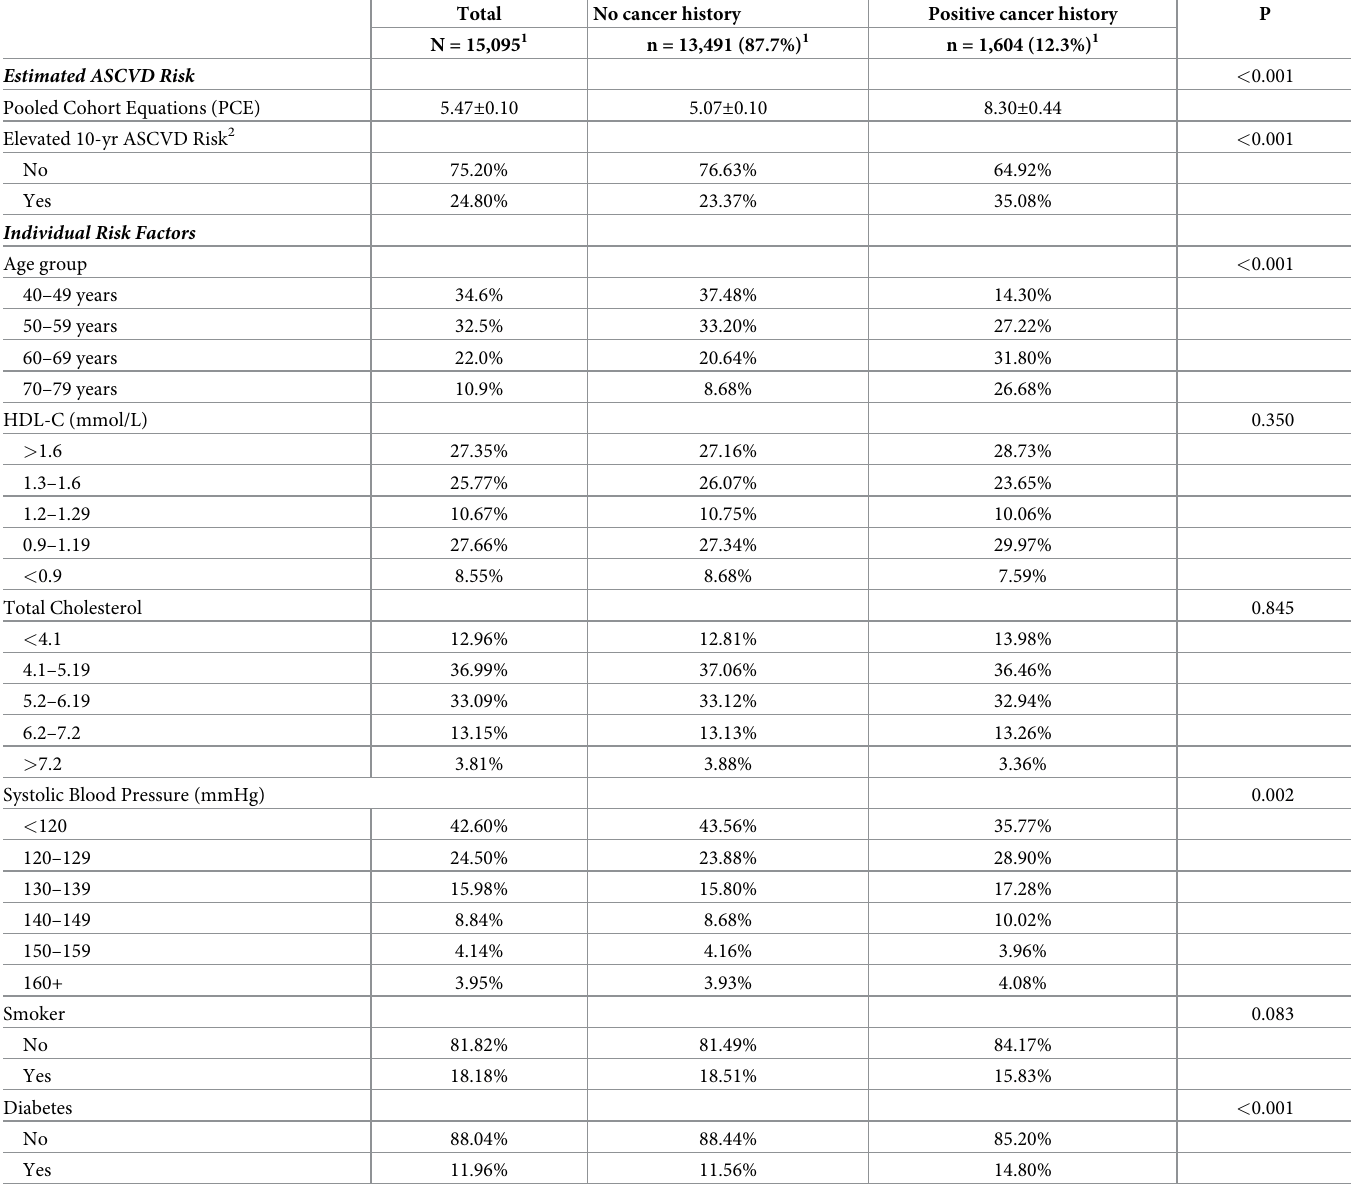
Table 2. Distribution of Pooled Cohort Equations and individual risk factors according to cancer status, 2007–2016